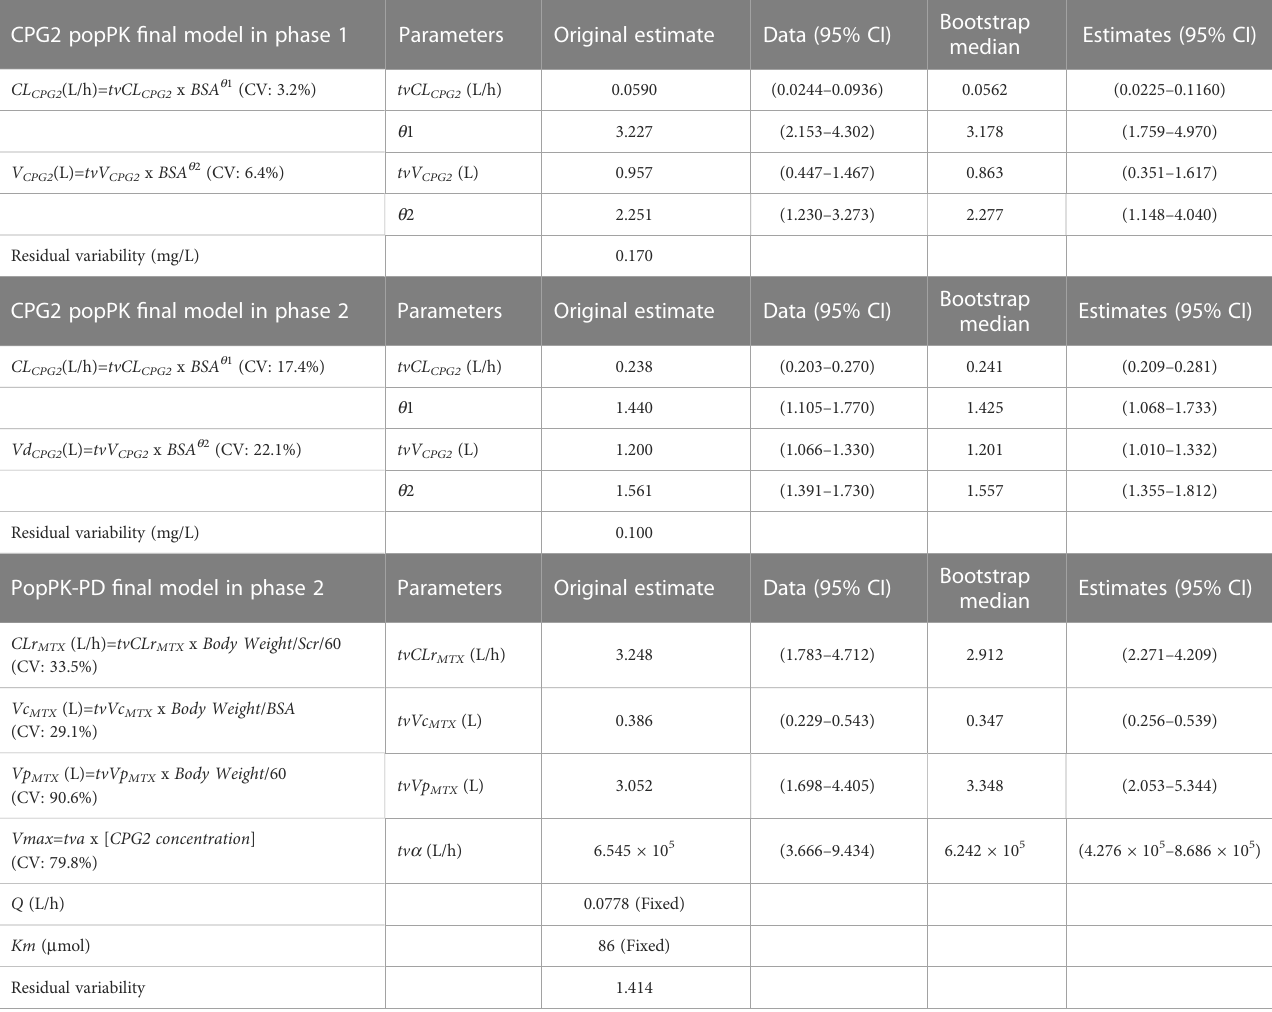
TABLE 4 The fi nal model and bootstrap